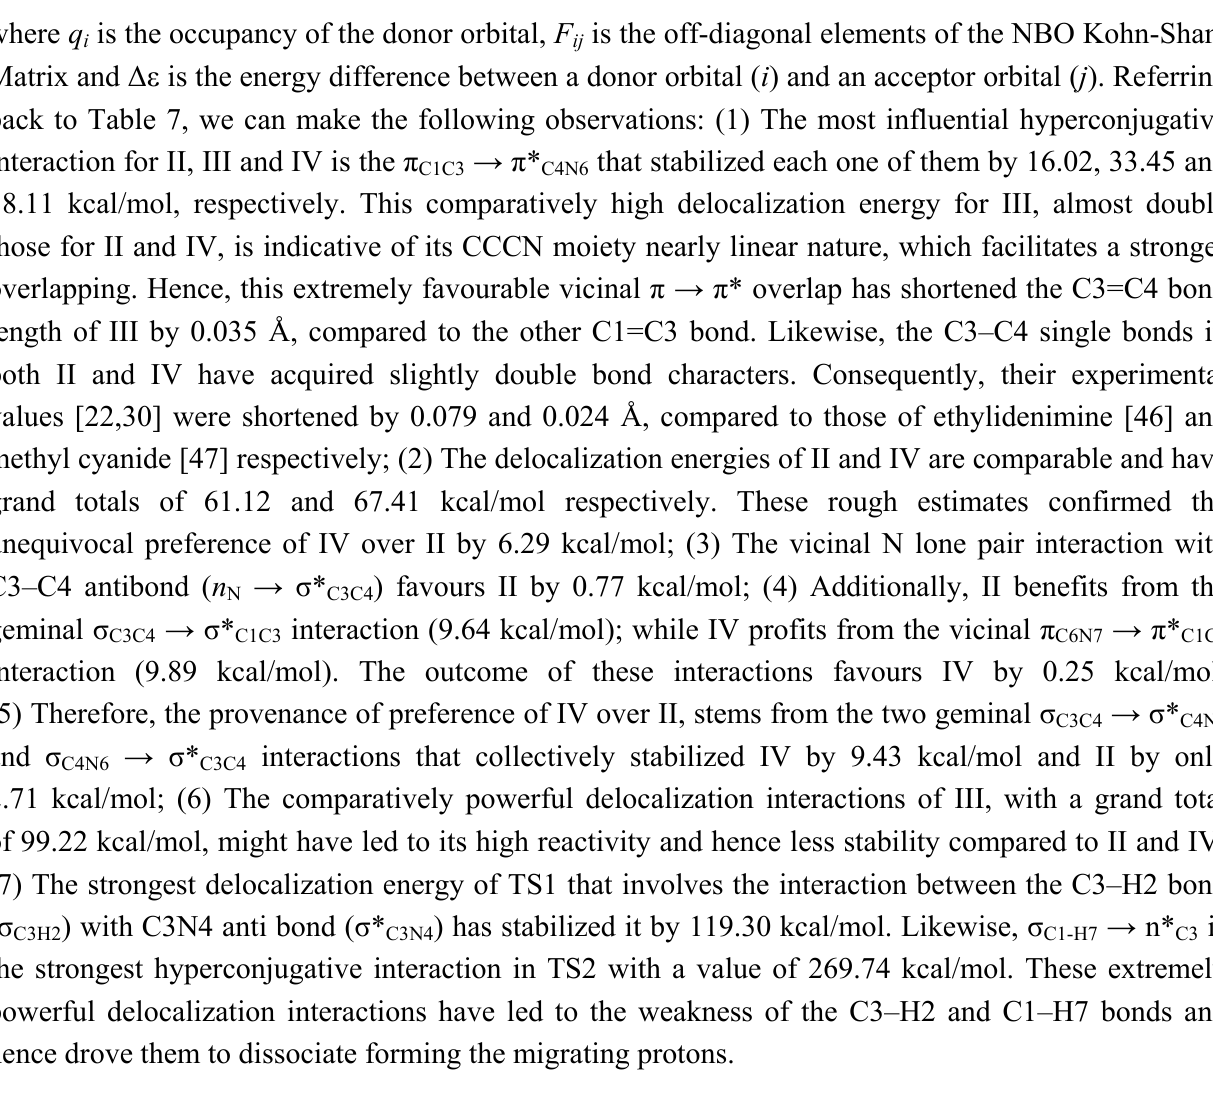
Table 7. Second order perturbation ( E (2)) estimation of the hyperconjugative energies (kcal/mol) a of Z-prop-2-ynylideneamine (II), intermediate (III), vinyl cyanide (IV), and Transition States (TS1 and TS2) which were calculated using B3LYP/aug-cc-pvdz level of